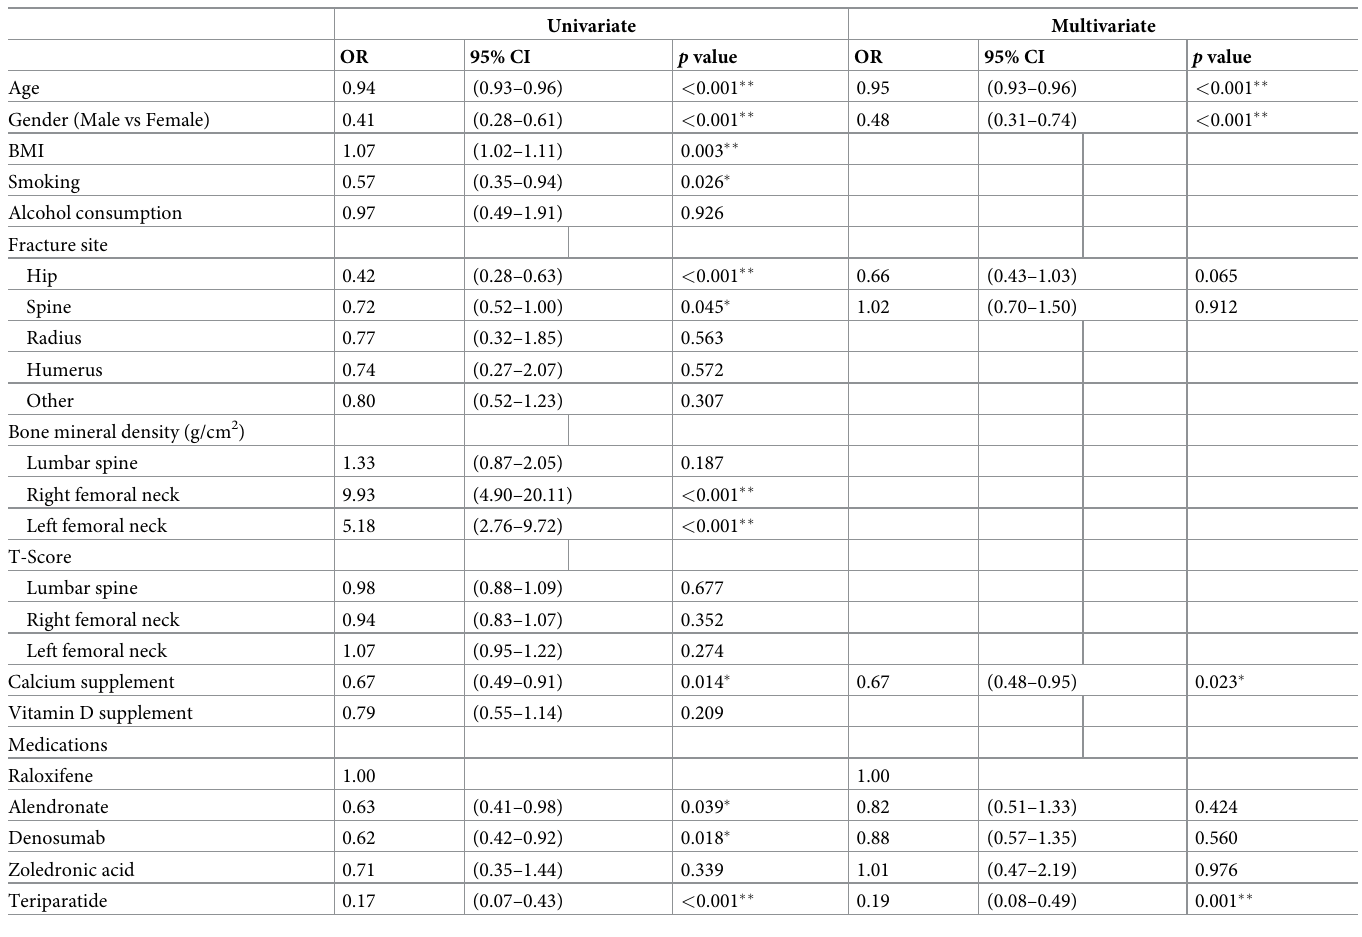
Table 3. Predictors for self-discontinuation of osteoporosis